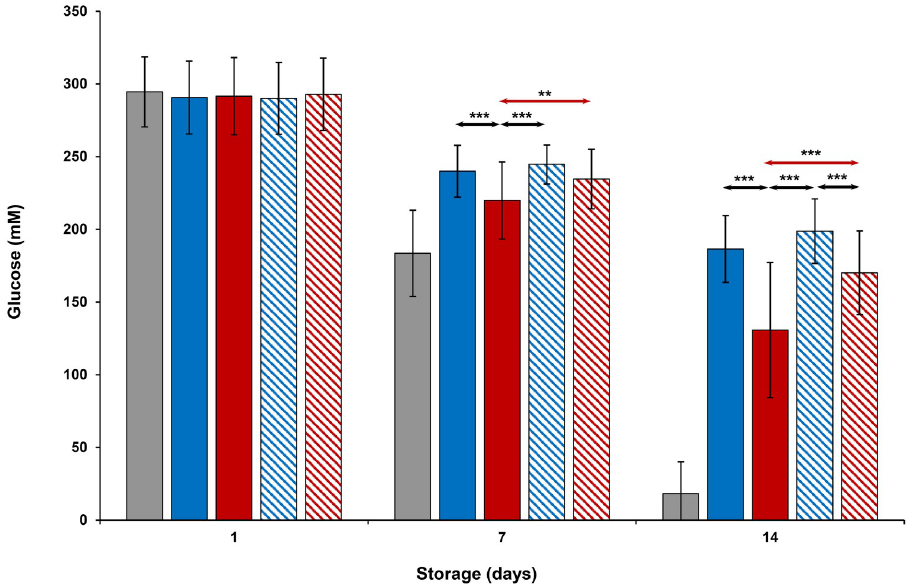
Fig 4. Effects of 14-day storage, temperature and presence of p38MAPK inhibitor on platelet glucose levels. Grey bar–platelets stored at room temperature; blue solid bar–cold-stored platelets; red solid bar–thermocycled-stored platelets; blue striped bar–cold-stored + VX-702 platelets; red striped bar–thermocycled-stored + VX-702 platelets. Data represents the mean of 15 experiments with one standard deviation. Arrows represent paired statistical differences; �� —p < 0.01, ��� —p < 0.001.